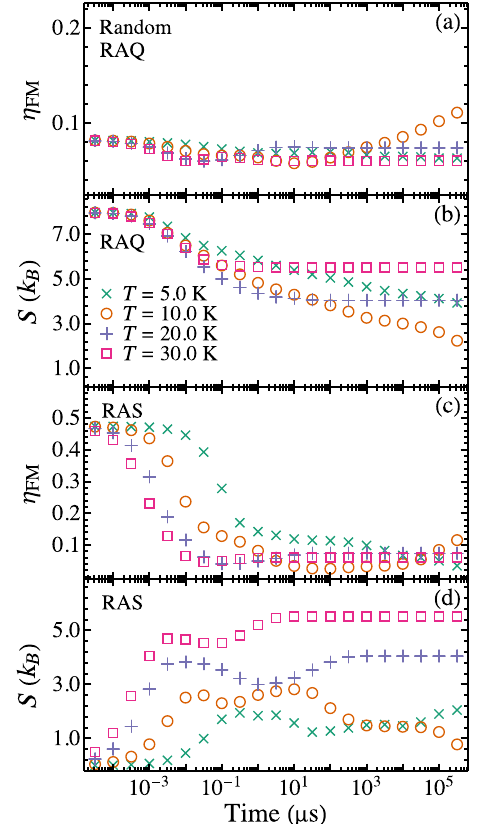
FIG. 10. Time dependence of the FM order parameter η configurational entropy S in the random ensemble of nonover- lapping NPs illustrated in Fig. 1(c). Results are given for the RAQ and for the RAS at different temperatures T